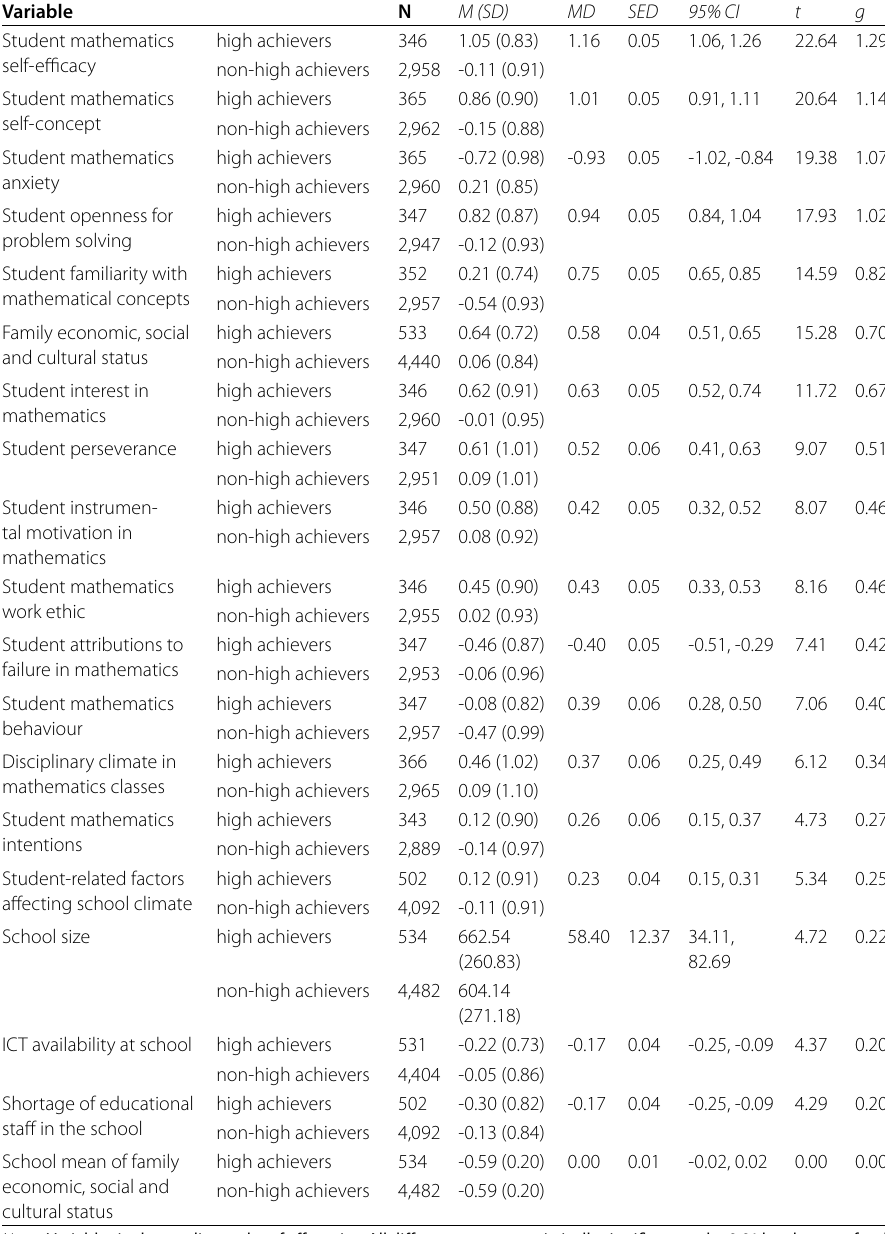
Table 3 Means in continuous background variables by mathematics performance group, PISA 2012